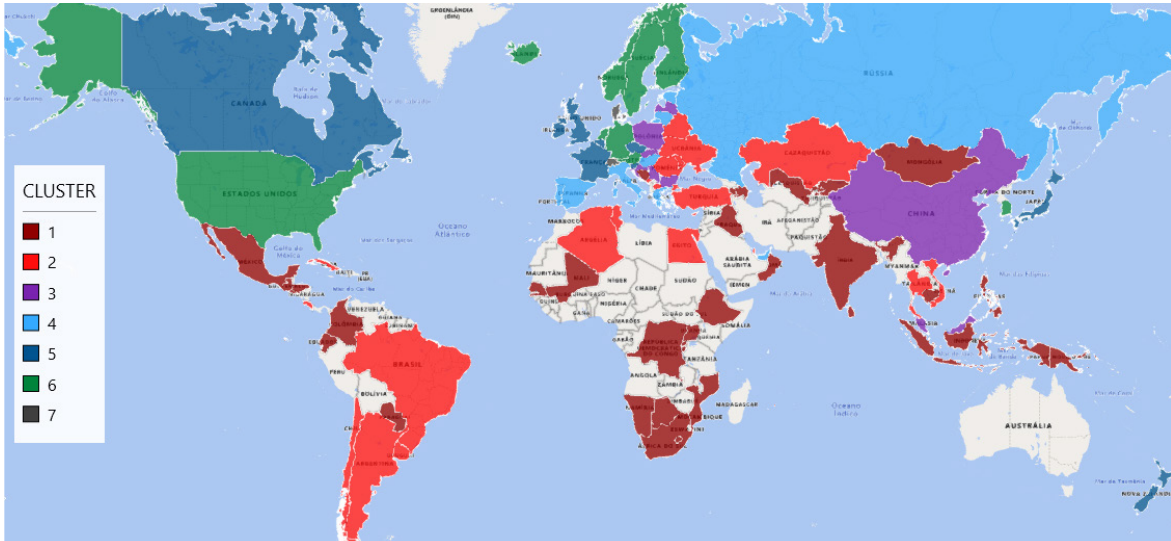
Figure 1. Clusters for countries (103) formed by % of investments in Gross Domestic Expenditure on Research and Development (lowest (1) to highest (7)). Economic data is from UNESCO´s Institue for Statistics (2013-2018). Countries in white do not have available data. Countries are listed in Table